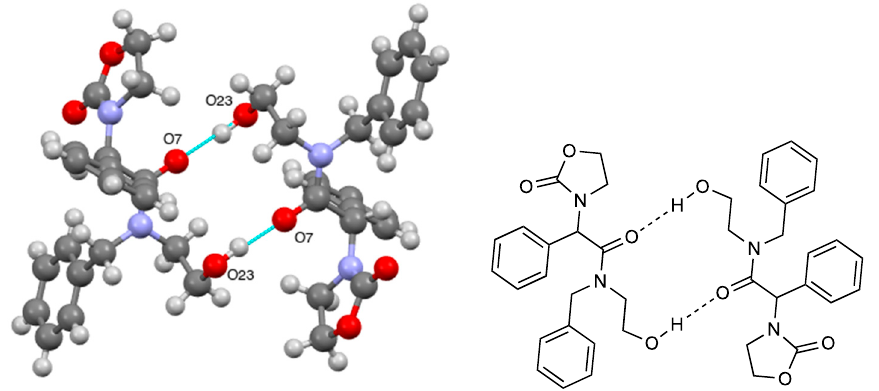
Figure 2. Hydrogen bonding pattern for compound 4 together with schematic representation. Table 1. Hydrogen bonding parameters for 4 (Å, °).